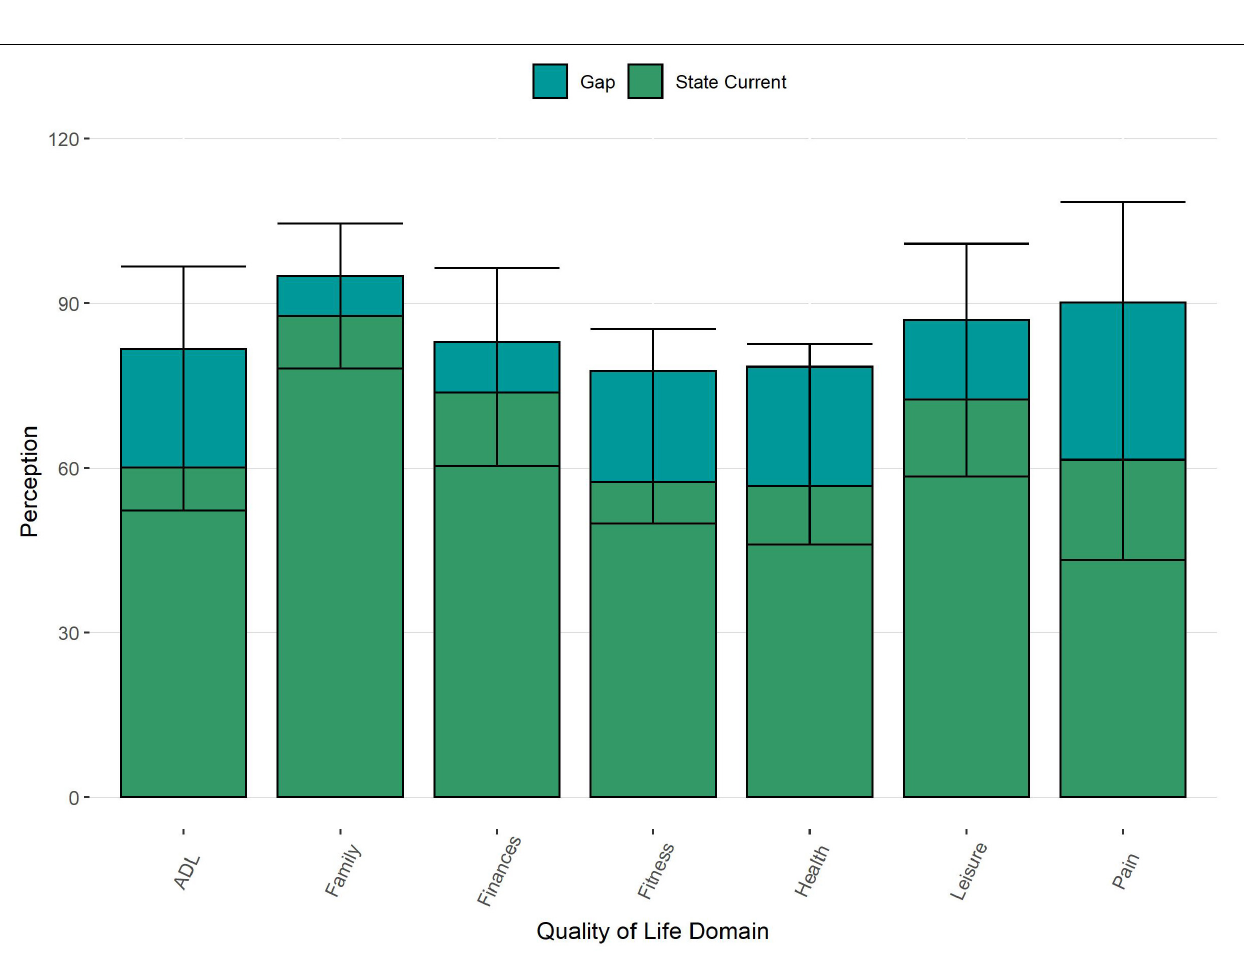
FIGURE 3 | Distribution and mean current and desired Quality of Life and the mean gap (with SD) for each domain. ADL, activities of daily living; the height of each bar represents the mean desired